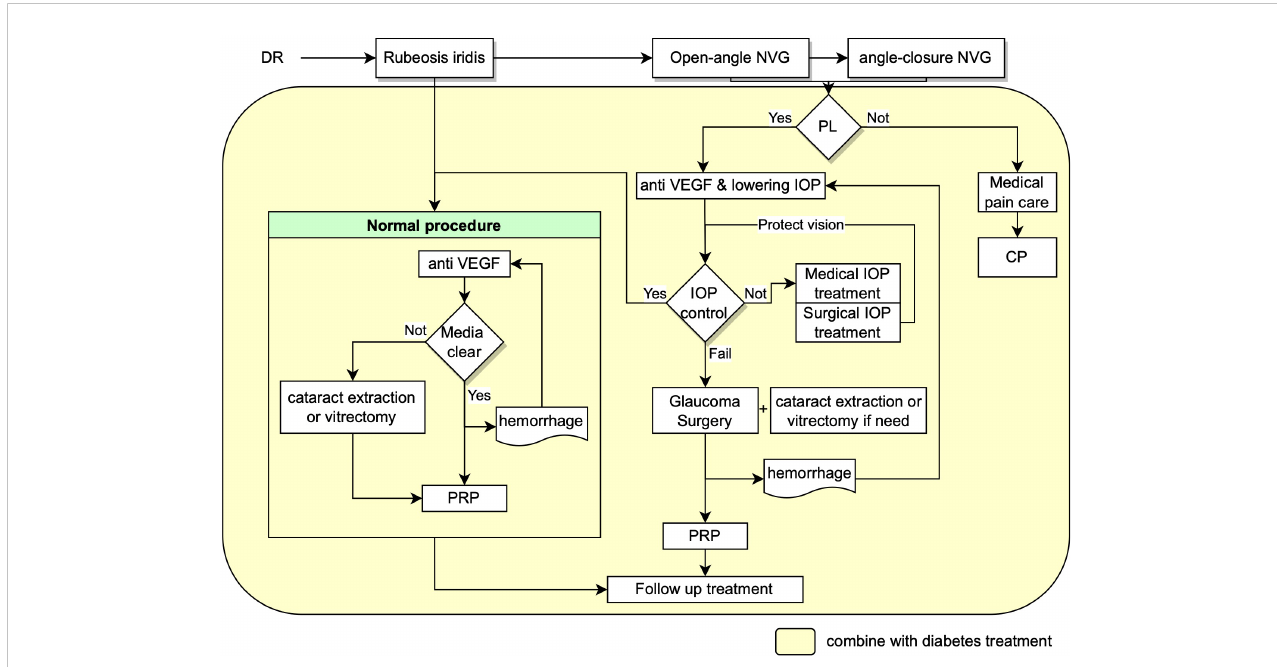
FIGURE 1 Flow chart showing the recommended management procedures for NVG secondary to DR. NVG: neovascular glaucoma, IOP: intraocular pressure, VEGF: Vascular endothelial growth factor, PRP: panretinal photocoagulation, PL: perception of light, CP: cyclodestructive